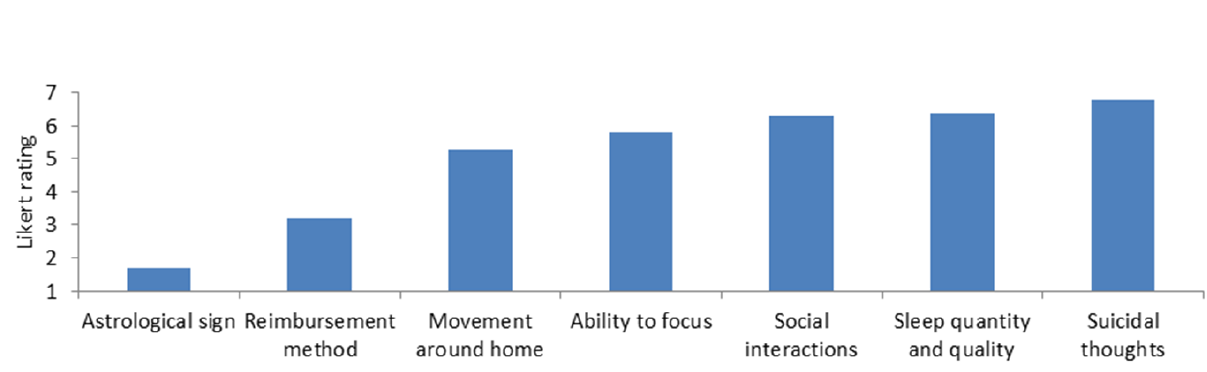
Figure 1. Perceived usefulness of indicators in guiding treatment.